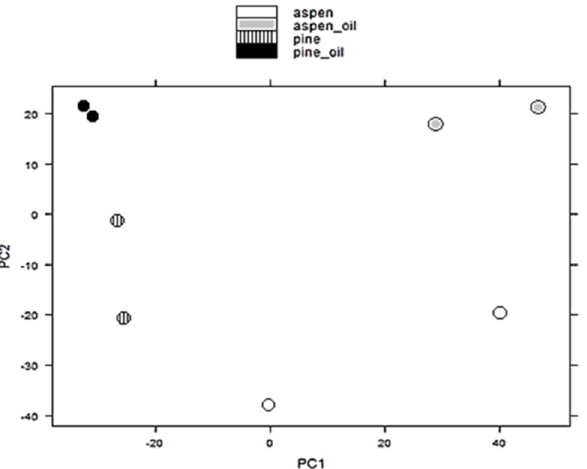
Fig 2. Biplot of principal components (PC) axes PC1 and PC2 derived from a Principal Components Analysis (PCA) of mapped paired-end Illumina RNA-Seq reads from 20 day-old Punctularia strigosozonata cultures in media treatments (aspen, aspen with Bunker C oil, pine, and pine with Bunker C oil). Ordination was completed in the R package DESeq.